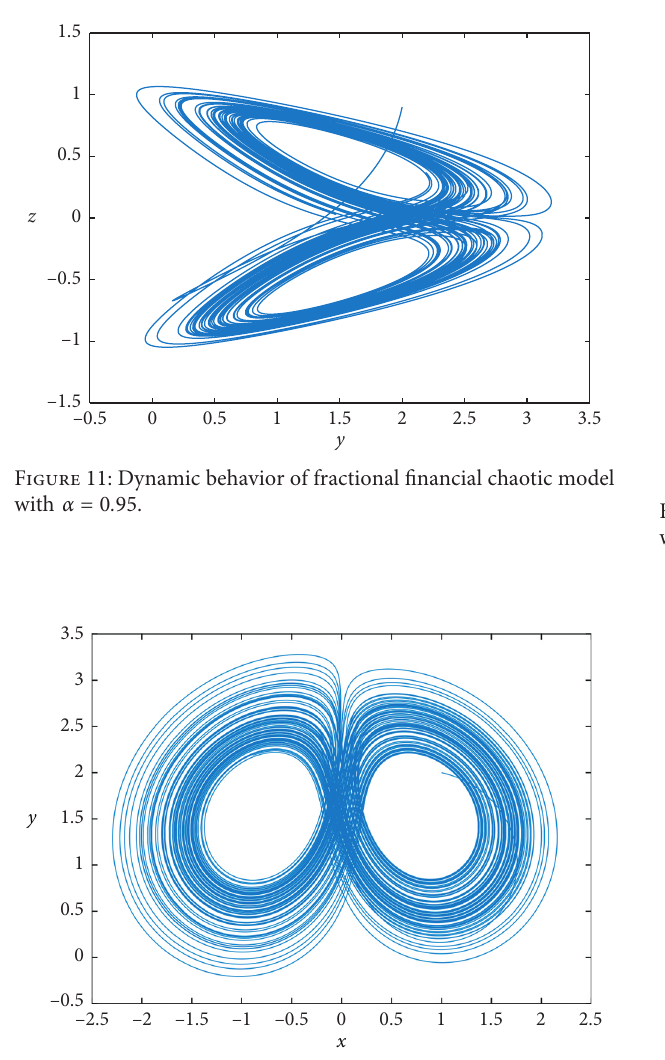
Figure 12: Dynamic behavior of fractional financial chaotic model with α � 0 . 95.